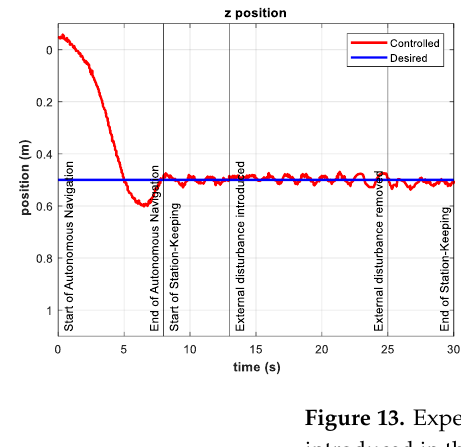
introduced in the interval 13 s ≤ t ≤ 25 s. Depth ( left ) and tracking error ( right ).